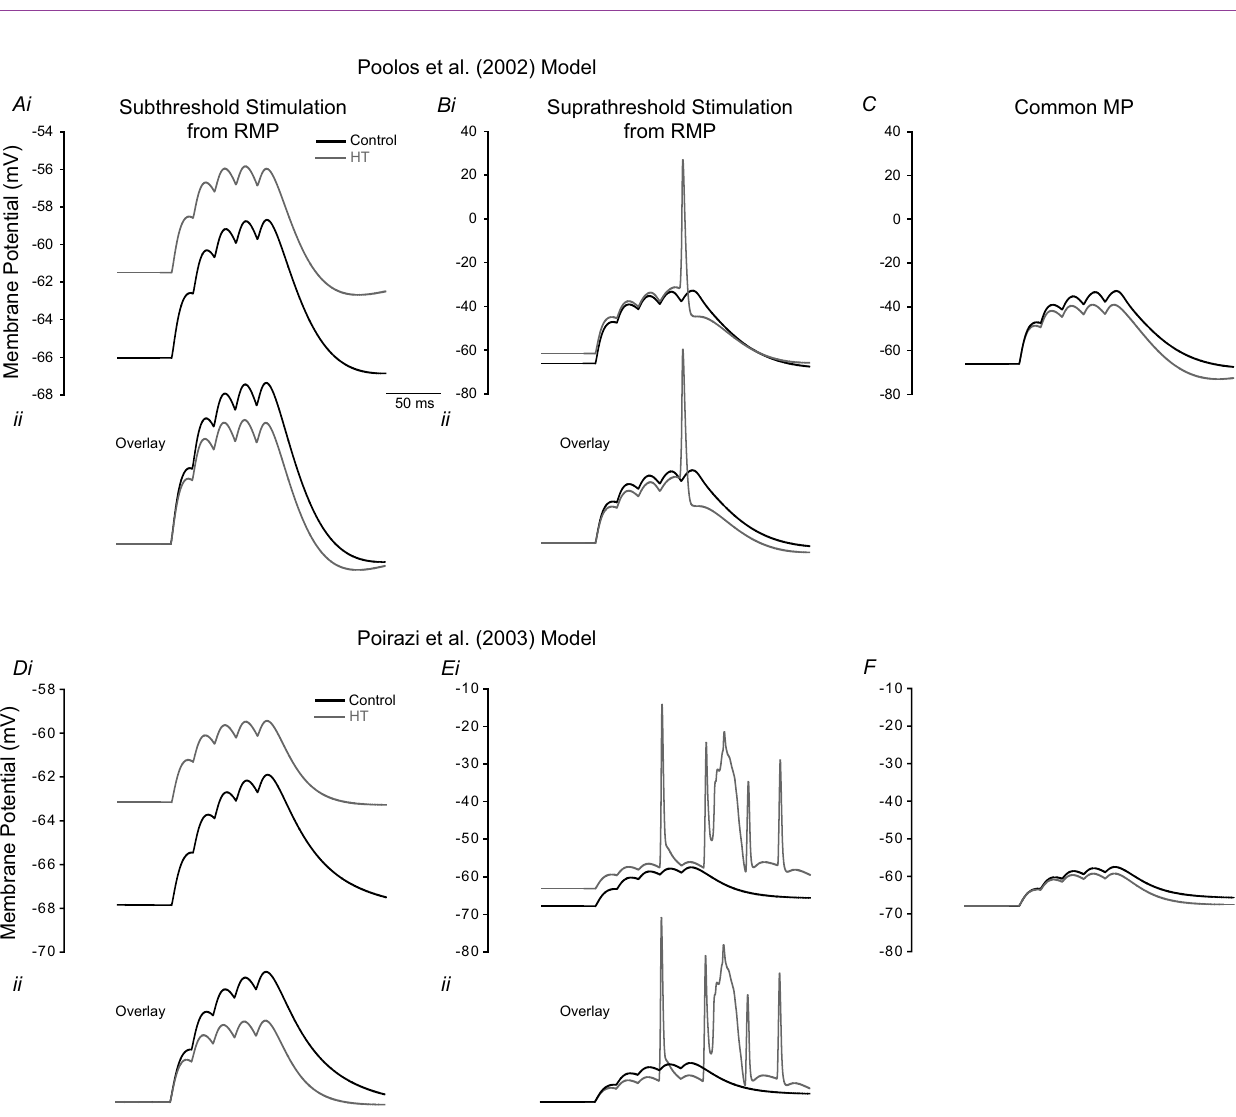
Figure 4. Model HT cell shows reduced EPSP summation but increased fi ring than control due to depolarized RMP. (A–C) refer to simulations performed using the Poolos et al. (2002) model, and (D–F) are simulations using the Poirazi et al. (2003) model. (Ai, Di) Train of fi ve small EPSPs from the RMP in control (black) and HT (grey) model cells. (Aii, Dii) Overlay of the traces in (Ai, Di) showing decreased EPSP summation in the HT model cells. (Bi, Ei) Train of fi ve large EPSPs, resulting in AP fi ring in the HT model cells (grey), but not in controls (black). (Bii, Eii) Overlay of the traces in (Bi, Ei) . (C, F) Train of fi ve large EPSPs in control (black) and HT (grey) model cells, from a common holding potential. Note that compensation of the depolarized RMP in the HT model cells eliminates AP fi